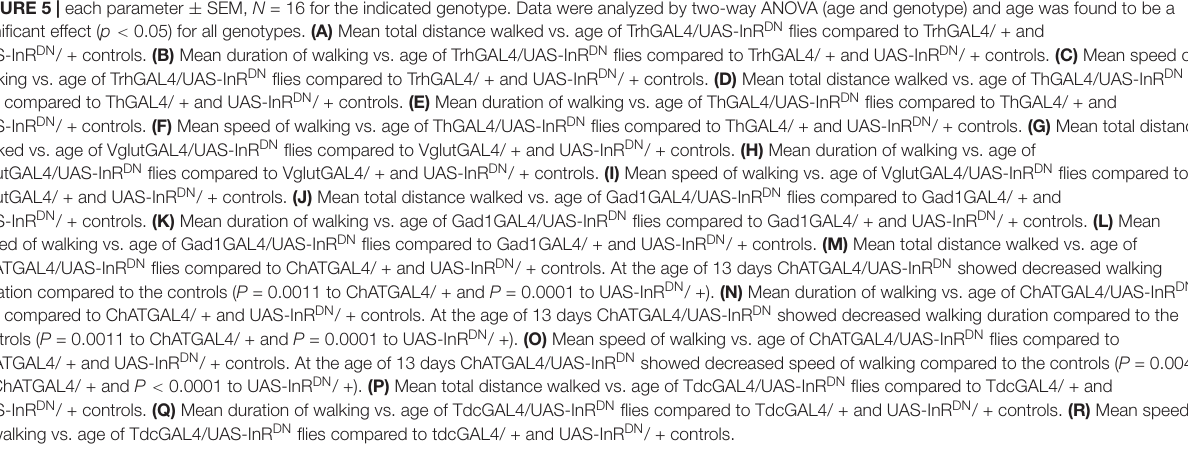
FIGURE 5 | each parameter ± SEM, N = 16 for the indicated genotype. Data were analyzed by two-way ANOVA (age and genotype) and age was found to be a significant effect ( p < 0.05) for all genotypes. (A) Mean total distance walked vs. age of TrhGAL4/UAS-InR DN flies compared to TrhGAL4/ + and UAS-InR DN / + controls. (B) Mean duration of walking vs. age of TrhGAL4/UAS-InR DN flies compared to TrhGAL4/ + and UAS-InR DN / + controls. (C) Mean speed of walking vs. age of TrhGAL4/UAS-InR DN flies compared to TrhGAL4/ + and UAS-InR DN / + controls. (D) Mean total distance walked vs. age of ThGAL4/UAS-InR DN flies compared to ThGAL4/ + and UAS-InR DN / + controls. (E) Mean duration of walking vs. age of ThGAL4/UAS-InR DN flies compared to ThGAL4/ + and UAS-InR DN / + controls. (F) Mean speed of walking vs. age of ThGAL4/UAS-InR DN flies compared to ThGAL4/ + and UAS-InR DN / + controls. (G) Mean total distance walked vs. age of VglutGAL4/UAS-InR DN flies compared to VglutGAL4/ + and UAS-InR DN / + controls. (H) Mean duration of walking vs. age of VglutGAL4/UAS-InR DN flies compared to VglutGAL4/ + and UAS-InR DN / + controls. (I) Mean speed of walking vs. age of VglutGAL4/UAS-InR DN flies compared to VglutGAL4/ + and UAS-InR DN / + controls. (J) Mean total distance walked vs. age of Gad1GAL4/UAS-InR DN flies compared to Gad1GAL4/ + and UAS-InR DN / + controls. (K) Mean duration of walking vs. age of Gad1GAL4/UAS-InR DN flies compared to Gad1GAL4/ + and UAS-InR DN / + controls. (L) Mean speed of walking vs. age of Gad1GAL4/UAS-InR DN flies compared to Gad1GAL4/ + and UAS-InR DN / + controls. (M) Mean total distance walked vs. age of ChATGAL4/UAS-InR DN flies compared to ChATGAL4/ + and UAS-InR DN / + controls. At the age of 13 days ChATGAL4/UAS-InR DN showed decreased walking duration compared to the controls ( P = 0.0011 to ChATGAL4/ + and P = 0.0001 to UAS-InR DN / +). (N) Mean duration of walking vs. age of ChATGAL4/UAS-InR DN flies compared to ChATGAL4/ + and UAS-InR DN / + controls. At the age of 13 days ChATGAL4/UAS-InR DN showed decreased walking duration compared to the controls ( P = 0.0011 to ChATGAL4/ + and P = 0.0001 to UAS-InR DN / +). (O) Mean speed of walking vs. age of ChATGAL4/UAS-InR DN flies compared to ChATGAL4/ + and UAS-InR DN / + controls. At the age of 13 days ChATGAL4/UAS-InR DN showed decreased speed of walking compared to the controls ( P = 0.0045 to ChATGAL4/ + and P < 0.0001 to UAS-InR DN / +). (P) Mean total distance walked vs. age of TdcGAL4/UAS-InR DN flies compared to TdcGAL4/ + and UAS-InR DN / + controls. (Q) Mean duration of walking vs. age of TdcGAL4/UAS-InR DN flies compared to TdcGAL4/ + and UAS-InR DN / + controls. (R) Mean speed of walking vs. age of TdcGAL4/UAS-InR DN flies compared to tdcGAL4/ + and UAS-InR DN / +